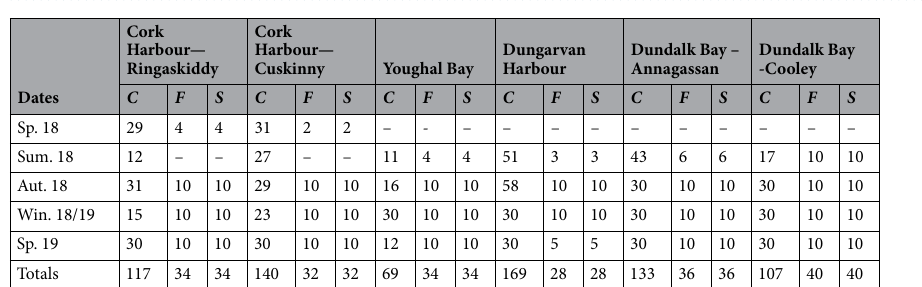
Figure 4. Map of Ireland highlighting the sample sites with coordinates (ArcGIS Desktop 10.5.1; www. esri. com).